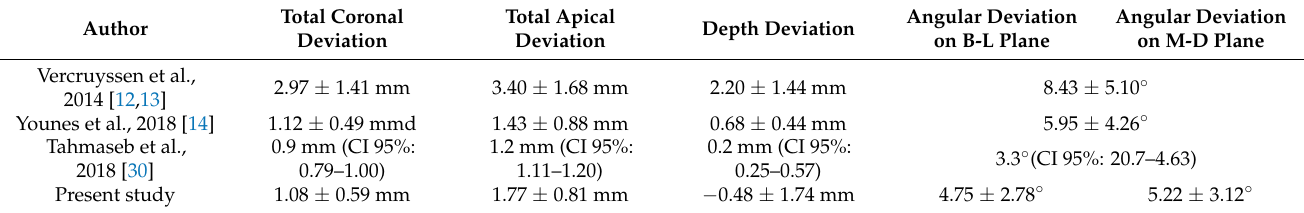
Table 2. Comparison of the results of the present study with previous publications investigating the use of pilot drill